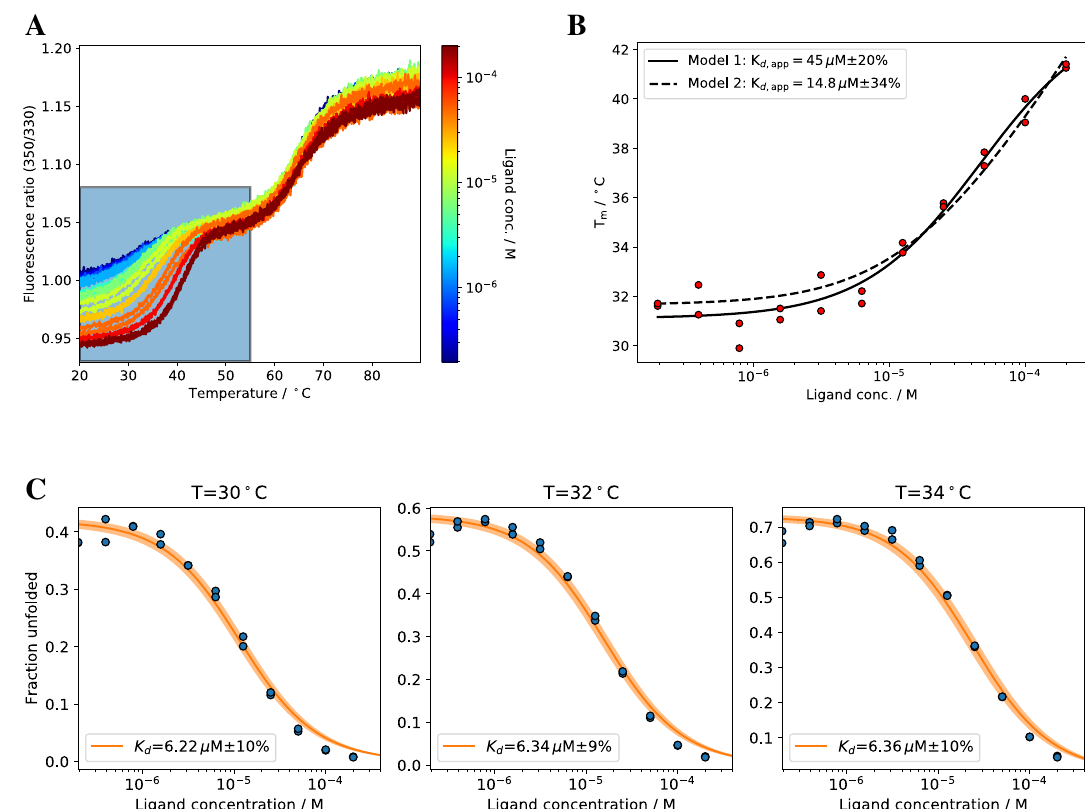
Figure 5. ( A ) nDSF binding study between MHC and the peptide NT8 (fluorescence ratio F 350 / 330 ). The region in the colored box was used for isothermal analysis (shown in C ). The ligand concentrations are color code from blue (low conc.) to red (high conc). ( B ) Melting temperature analysis with two different models yields apparent K d,app values. ( C ) Isothermal analysis with a ∆ C p = 0. The same analysis for a fitted ∆ C p is show in supplementary information